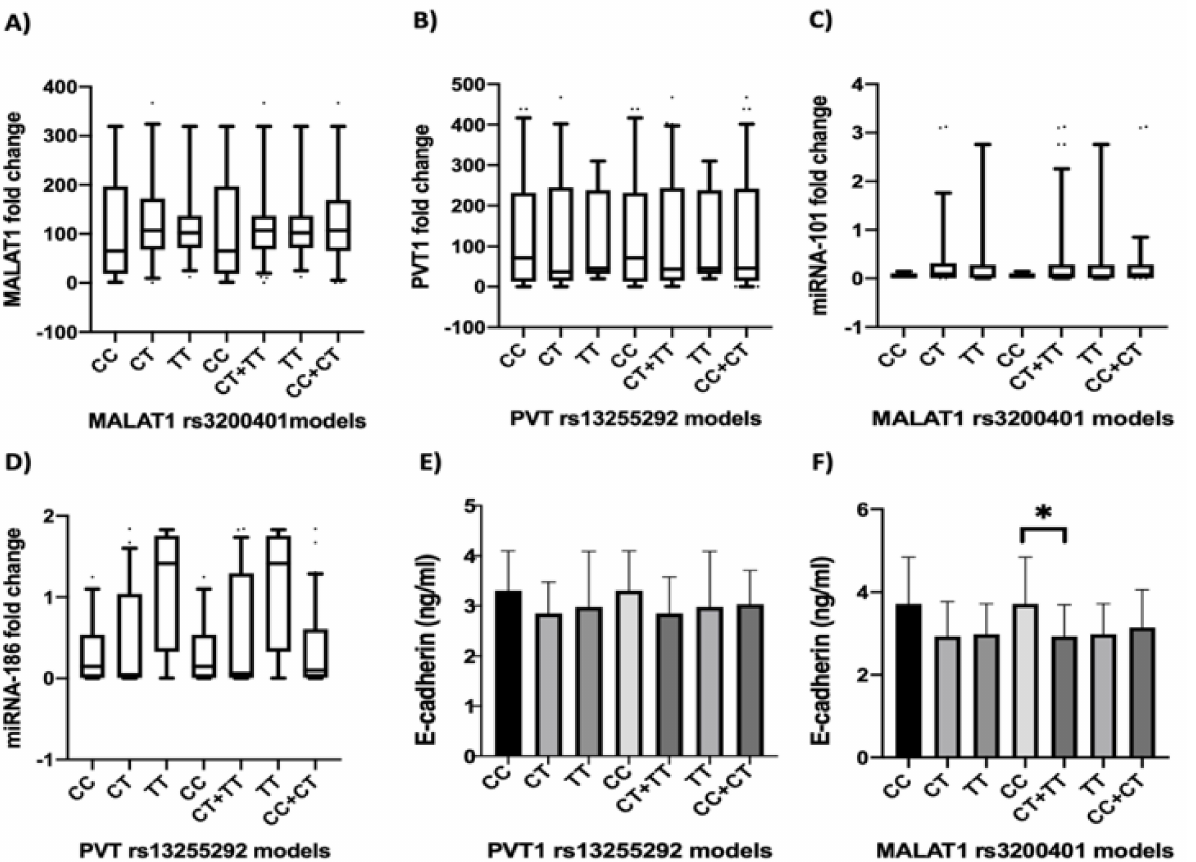
Figure 3. Serum MALAT1 , PVT1 , miRNA-101 , miRNA-186 and E-cadherin expression levels in CRC patients with different rs3200401 and rs13255292 genotypes. The box represents the 25%–75% percentiles; the line inside the box represents the median and the upper and lower lines representing the 10%–90% percentiles of the fold change of serum ( A ) MALAT1I , ( B ) PVT1 , ( C ) miRNA-101 and ( D ) miRNA-186 . ( E , F ) The bars represent the mean and SD of serum E-cadherin.* means statistical significance p <